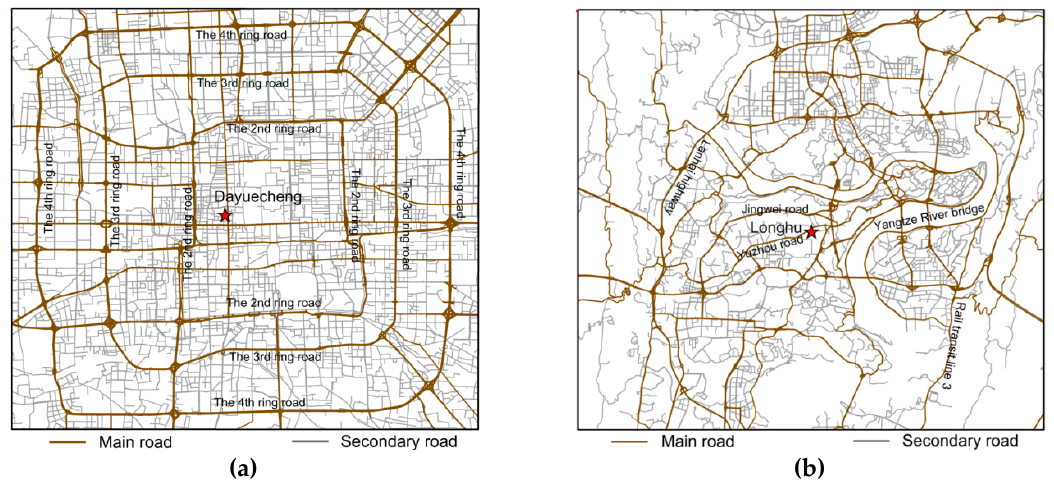
Figure 1. Locations (represented by the red pentagrams) of ( a ) Dayuecheng (DYC) and ( b ) Longhutianjie (LH).